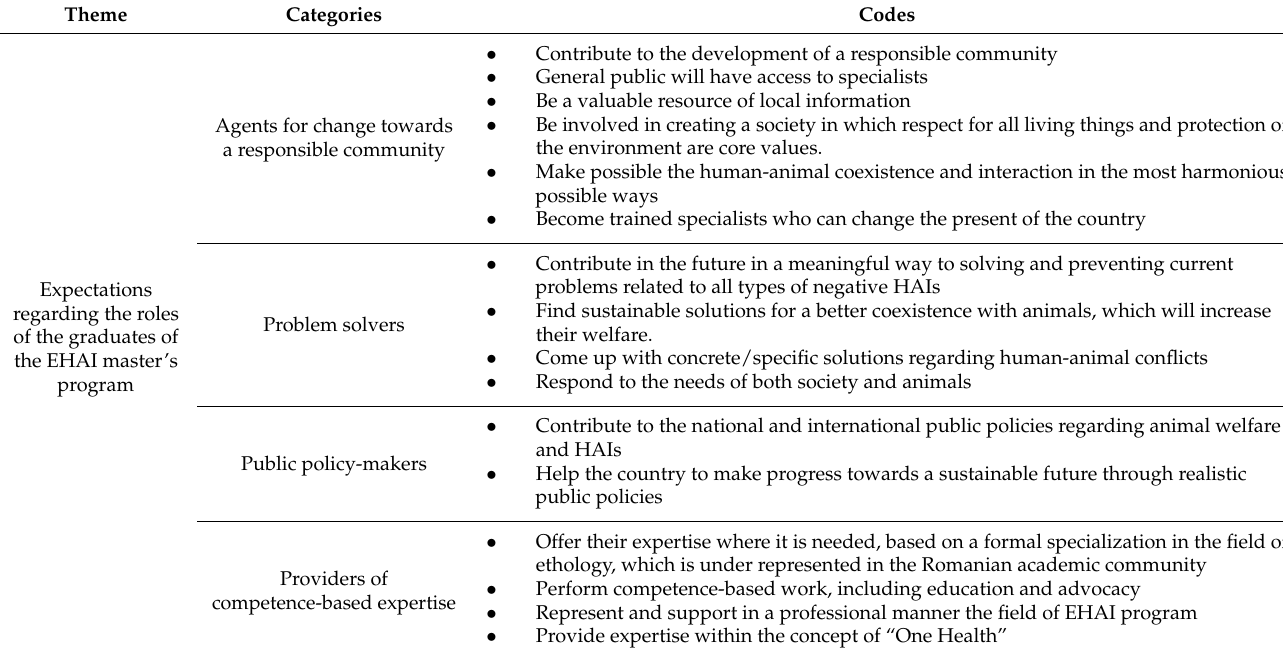
Table 2. Presentation of the categories and the codes corresponding to the theme “Expectations regarding the roles of the Ethology & Human-Animal Interaction (EHAI) master’s degree graduates on the collaboration with the NGOs in addressing common problems in the area of Human-Animal Interactions (HAIs) in